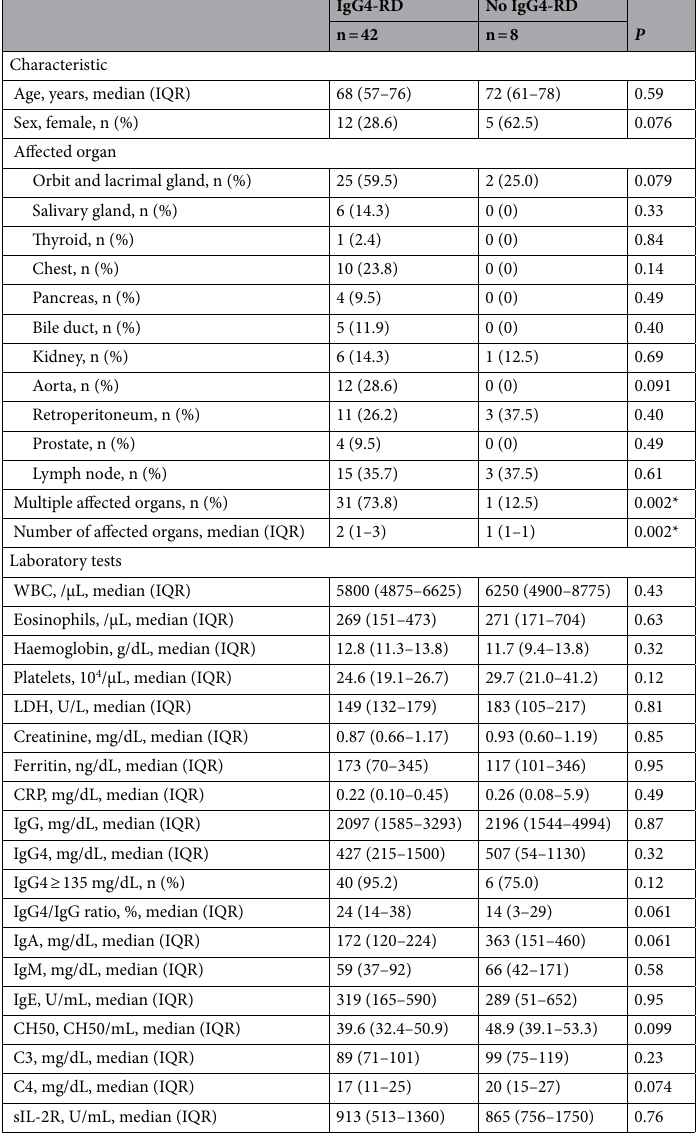
Table 1. Characteristics of patients with versus without IgG4-RD. P values were determined using the Mann– Whitney U test or Fisher’s exact test, as appropriate. * P < 0.05. IgG4-RD immunoglobulin G4-related